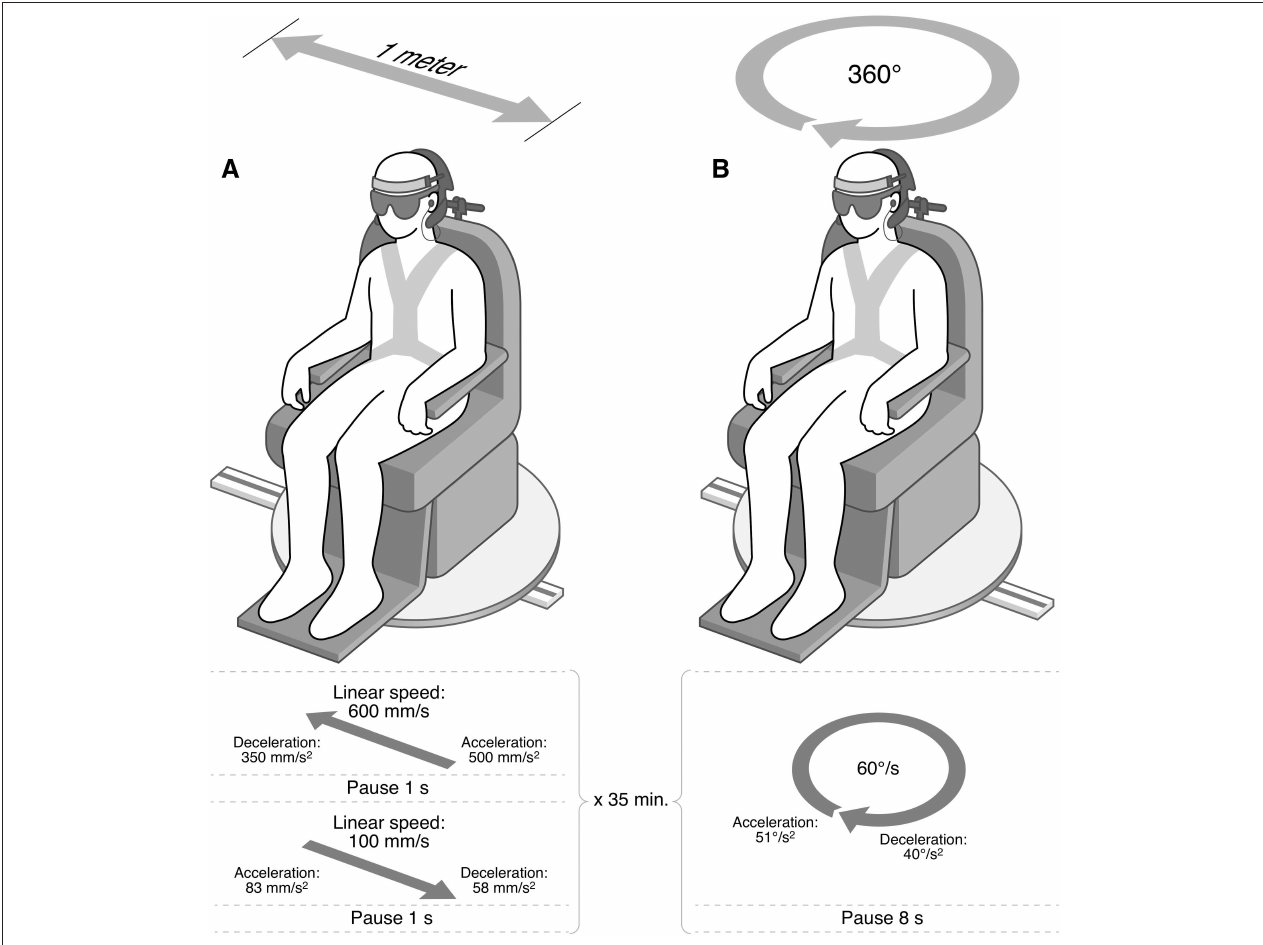
FIGURE 1 | The self-propelled chair. The participants were seated in the self-propelled chair. During vestibular stimulation and baseline they wore noise-canceling earphones and sleep-goggles. Angular stimulation : The chair rotated 360 ◦ clockwise (Acceleration: 51 ◦ /s 2 , speed: 60 ◦ /s) followed by an 8s pause before initiating the next rotation. The chair repeated this pattern for 35min. The chair performed clockwise rotations in order to create a predominantly right-sided stimulus of the semicircular canal. Linear stimulation : The chair moved rapidly to the right (acceleration: 500 mm/s 2 , speed: 600 mm/s) then paused for 1s before slowly (Acceleration: 83 mm/s 2 , speed: 100 mm/s) returning to the starting position. This movement pattern was repeated for 35min. The chair performed cycles of rapid rightward movements and slow leftward movements during 35min of stimulation in order to create a predominantly right-sided utricular